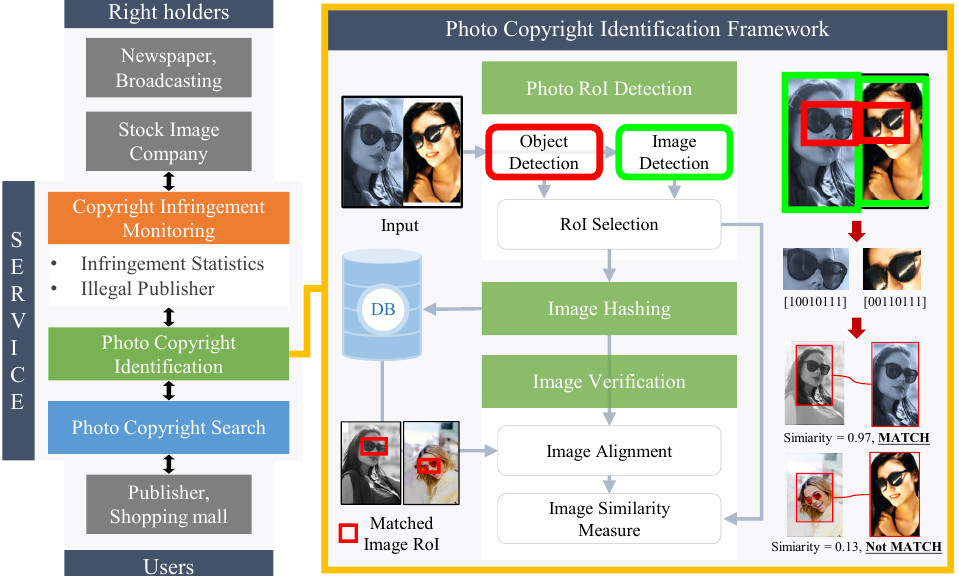
Figure 4. Service block diagram for the photo copyright search. The yellow box on the right side is the proposed photo copyright identification framework in this